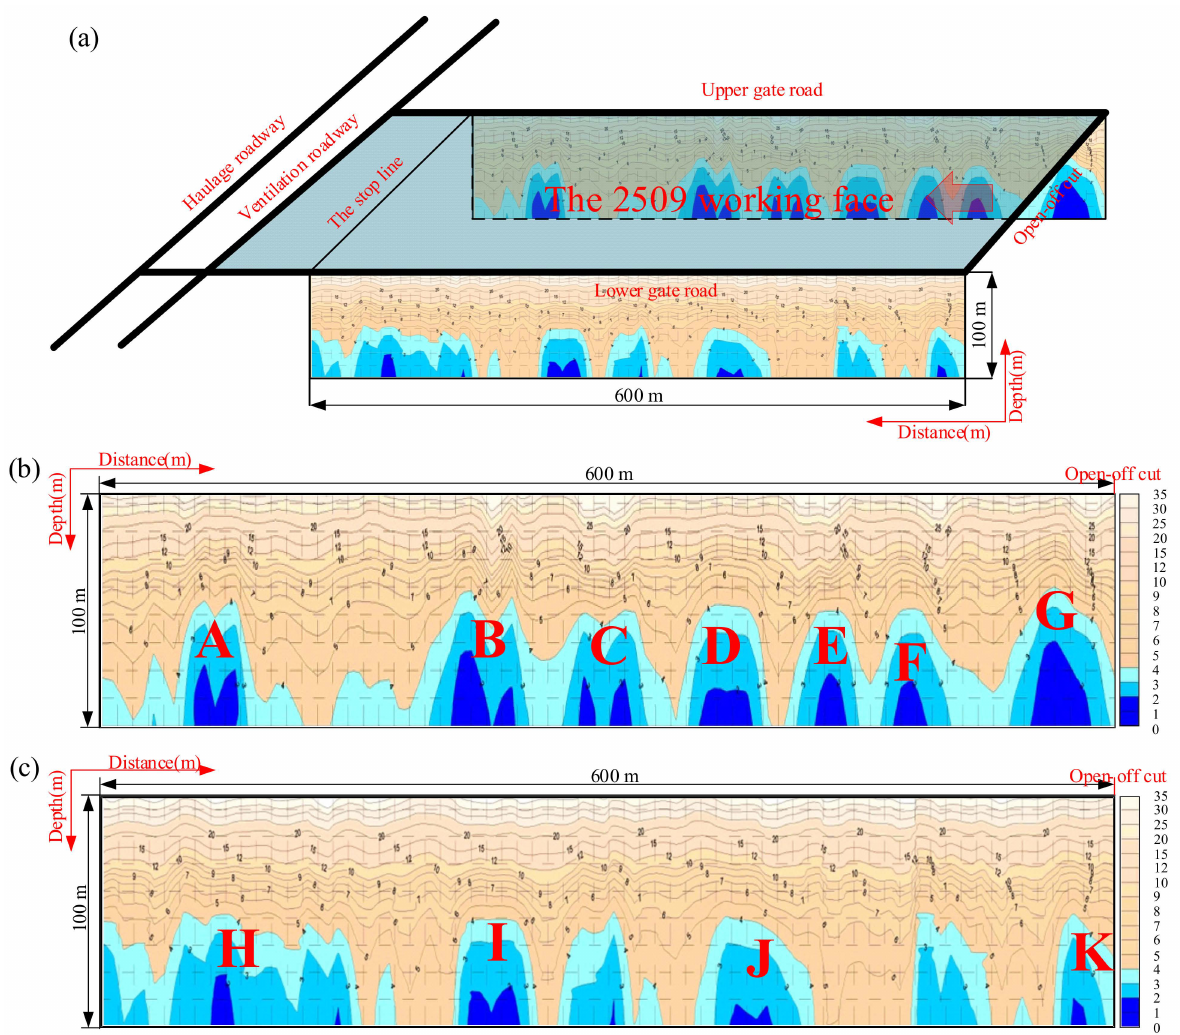
Figure 6. TEM results along the gate road of Working Face 2509 before grouting: ( a ) TEM detection profile; ( b ) the upper gate road; ( c ) the lower gate road.